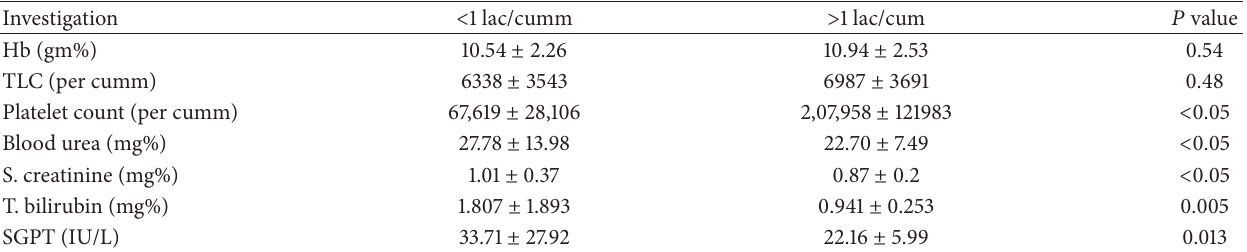
Table 3: Difference in results of investigations between the two groups.